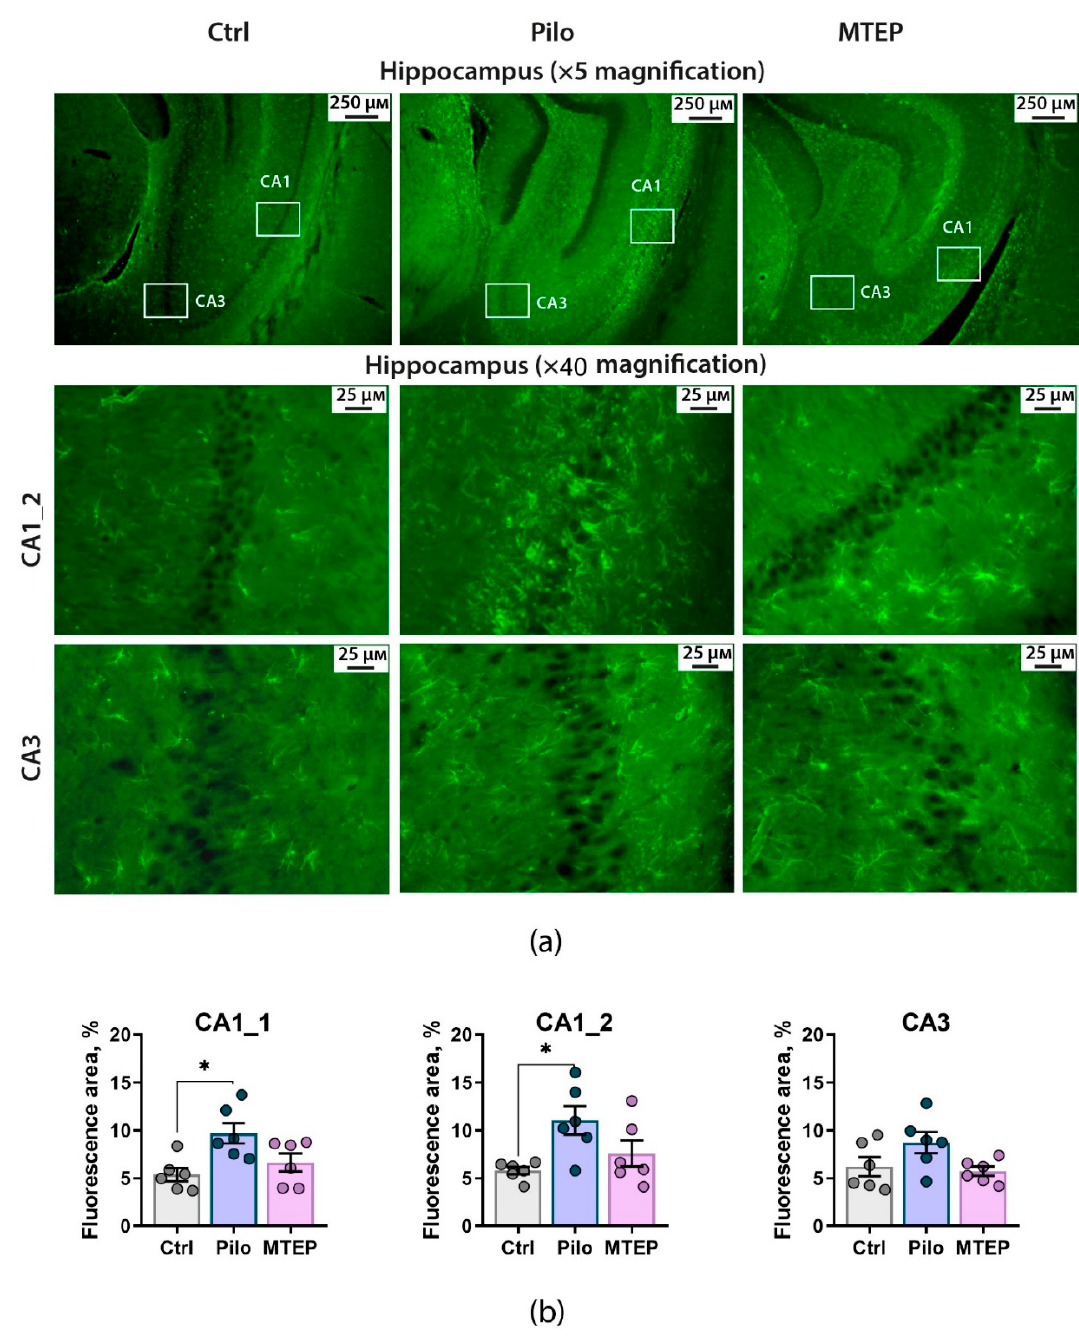
Figure 5. GFAP immunofluorescence analysis of the hippocampal tissue. ( a ) Representative images of hippocampal sections with GFAP-positive cells. Brain tissue was analyzed two months after pilocarpine-induced SE. Immunohistochemistry targeting glial fibrillary acidic protein (GFAP) was used to detect astrocytes. MTEP therapy reduces astrogliosis in the rat hippocampus. ( b ) The averaged GFAP-positive areas in different hippocampal sites: CA1_1, CA1_2, and CA3. The circles show individual values per brain. The columns indicate average values and error bars show standard errors of the means. One-way ANOVA was performed to determine the effects of MTEP therapy on astrogliosis: CA1 (F 2,15 = 5.9; p < 0.05); CA2-CA1 (F 2,15 = 8.4; p < 0.05); CA3 (F 2,15 = 4.95; p = 0.07). Asterisks indicate significant differences between groups according to Tukey’s post hoc tests: * p < 0.05.